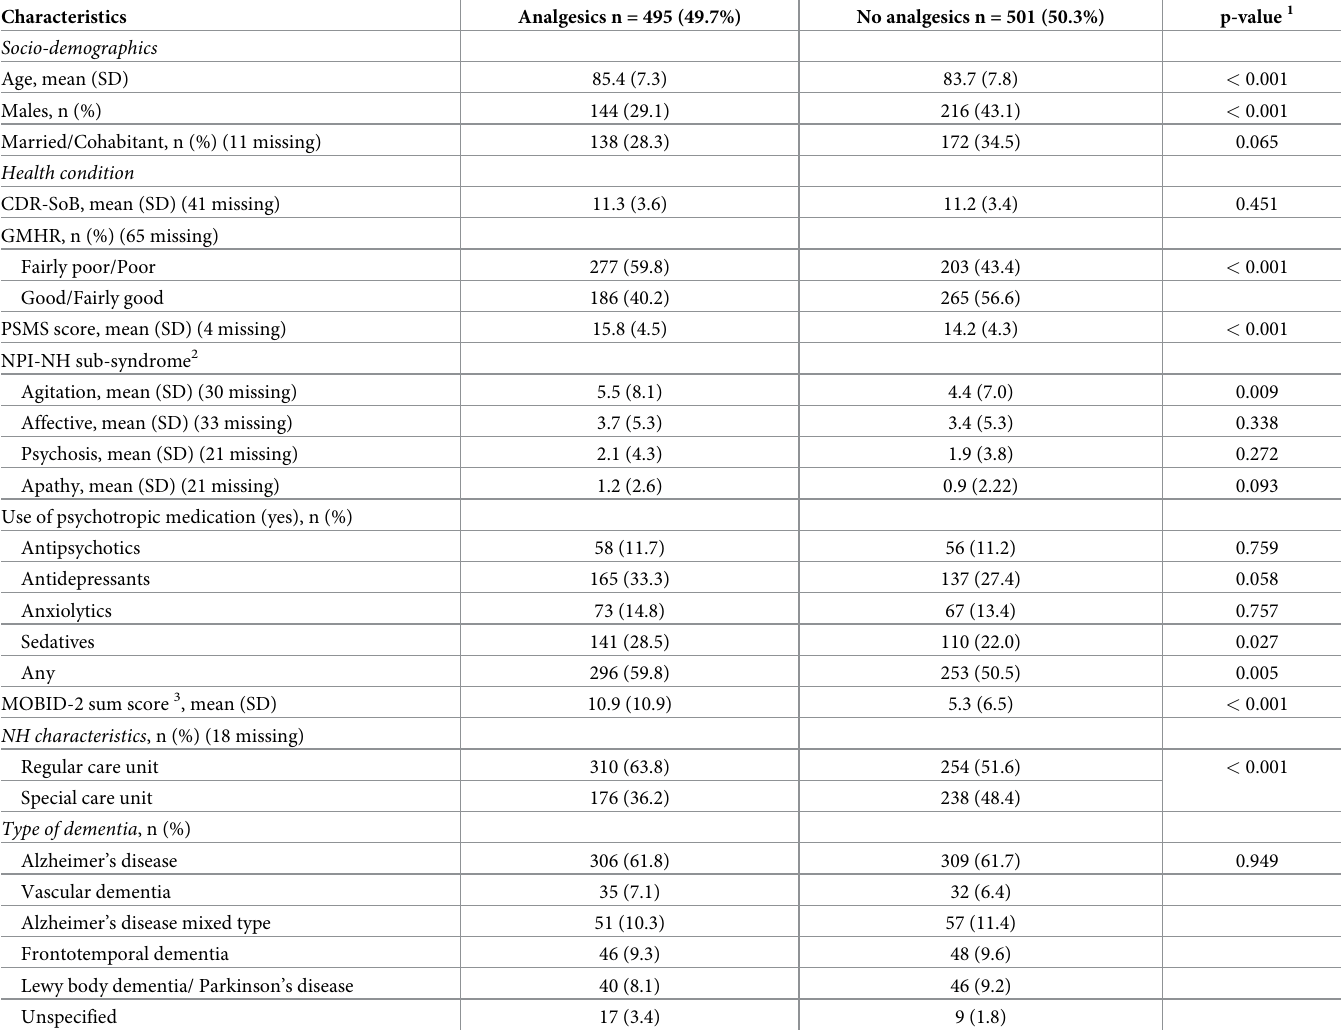
Table 1. Sample characteristics of newly admitted NH residents with dementia (N = 996).